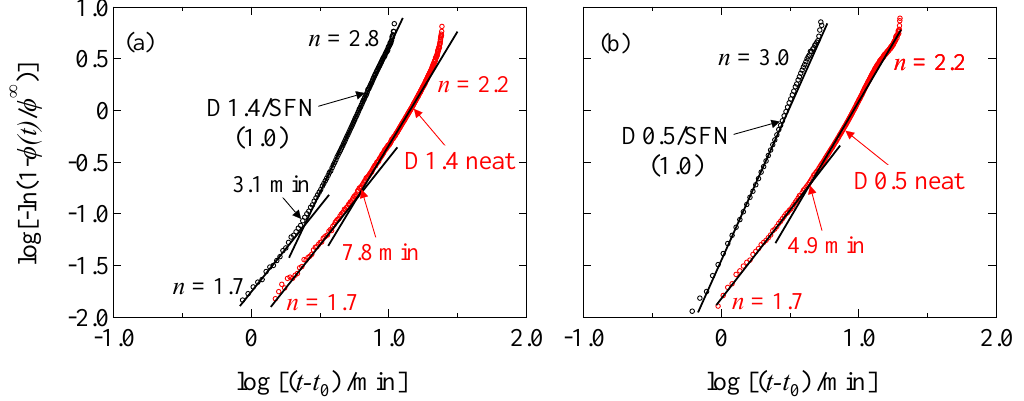
Figure 7. Avrami plots based on the WAXS results as shown in Figure 2 for ( a ) D1.4 specimens and ( b ) D0.5 specimens. Here, t 0 denotes the induction period.